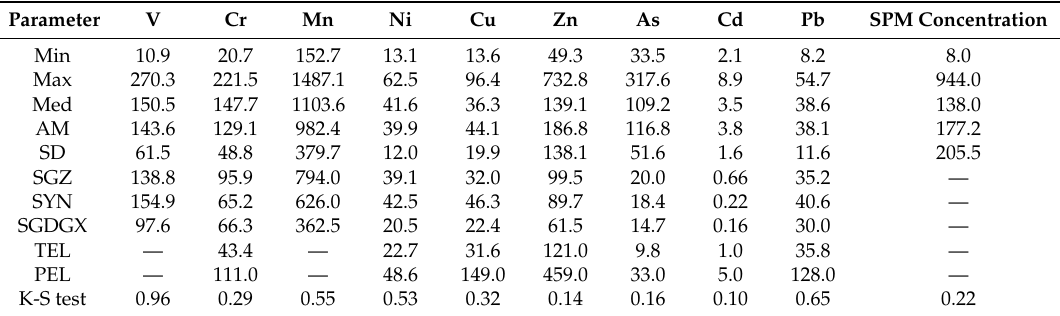
Table 3. Descriptive statistics of heavy metal(loid)s in suspended particulate matter (SPM) and the SPM concentration of the Zhujiang River ( n = 22), and the local soil background values of the Zhujiang River